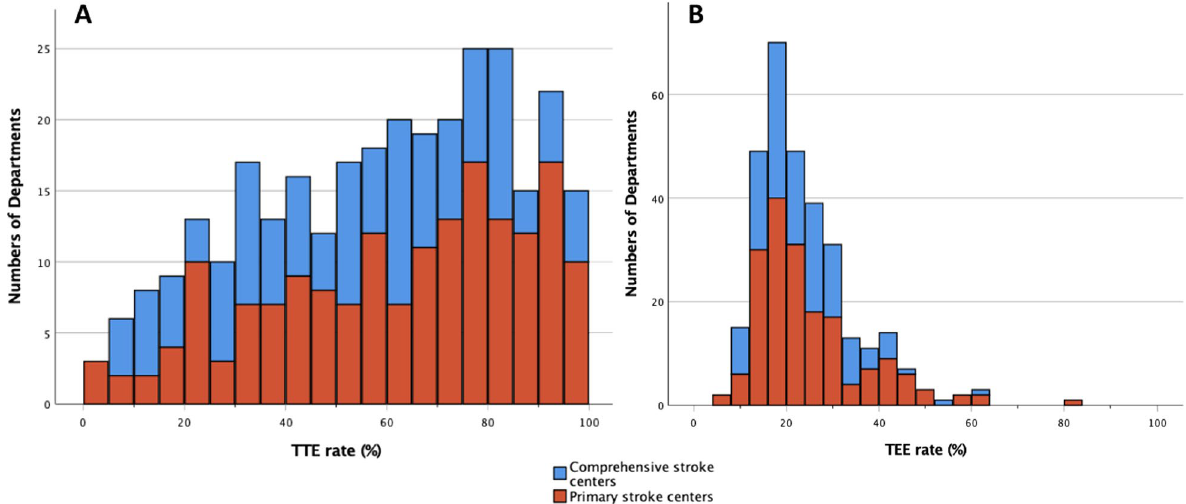
Fig. 1 A Bar chart for TTE rates per patients for primary and comprehensive stroke centers. B Bar chart for TEE rates for primary and comprehensive stroke